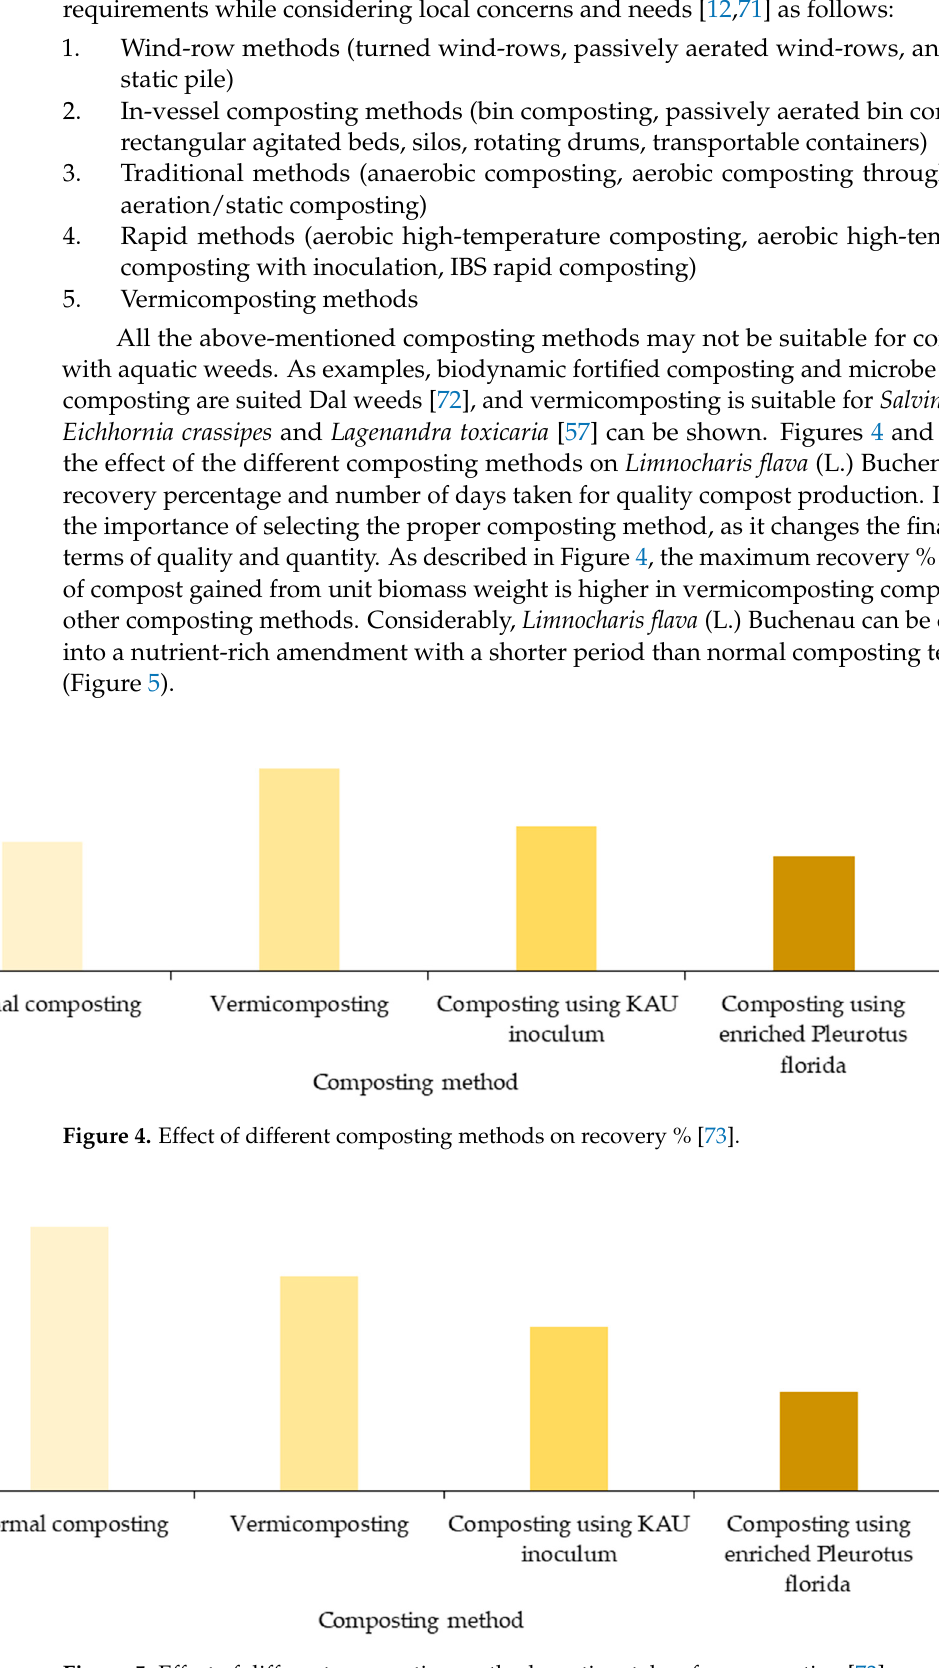
Figure 5. Effect of different composting methods on time taken for composting [73]. Different production techniques lead to different processing conditions, composting times, and micro-organism corporations with various stability, maturity, and sanitation potencies. That will result in different final products with different qualities and compo- sitions as different nutrient contents (Figure 6).